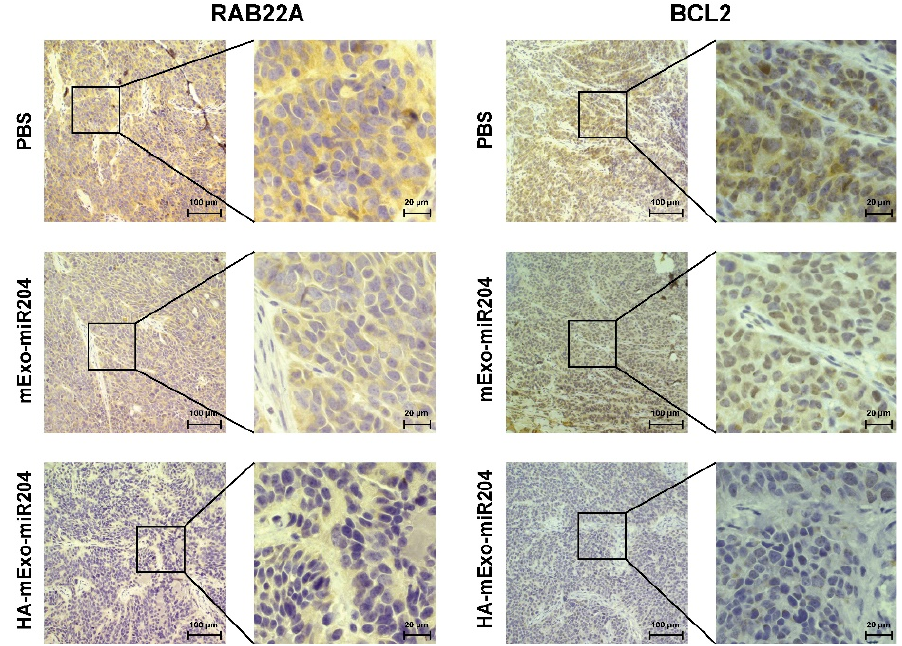
Figure 5. IHC analysis of RAB22A and BCL2 protein expressions in xenograft tumor. Sections of tumor tissues from mice were stained with RAB22A and BCL2 antibodies. Black boxed regions are enlarged in the right images. Scale bars: 100 μ m (left); 20 μ m (right).